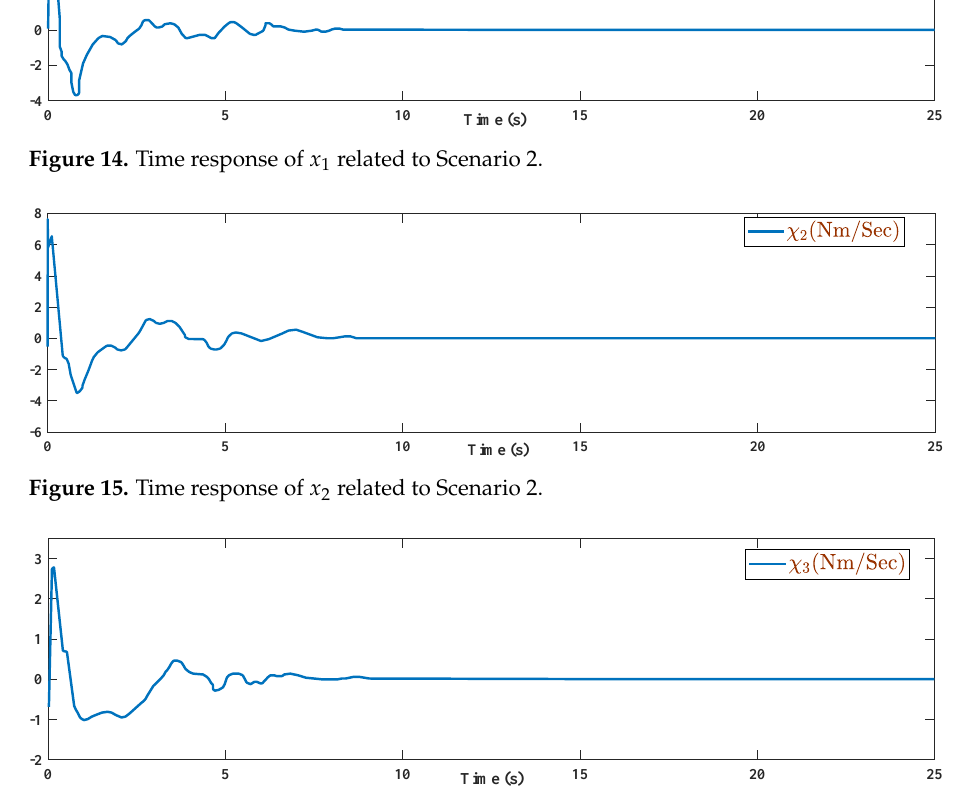
Figure 16. Time response of x 3 related to Scenario